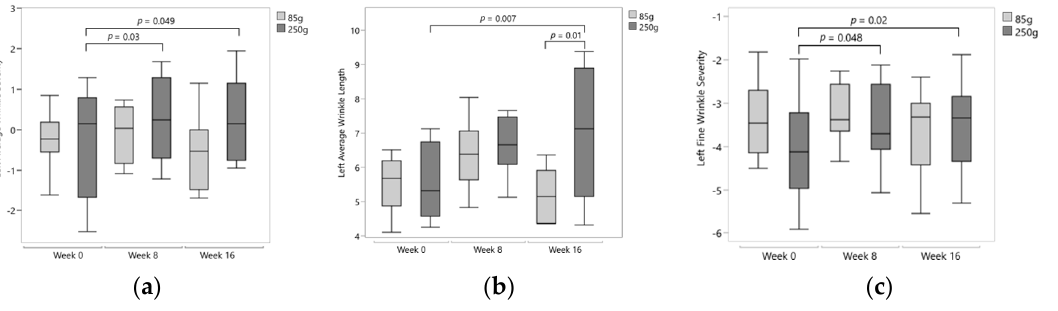
Figure 4. ( a ) Left average wrinkle severity significantly increased at week 8 ( p = 0.03) and week 16 ( p = 0.049) after 250 g of mango intake. Data transformed by Johnson transformation. ( b ) Left average wrinkle length significantly increased at week 16 ( p = 0.007) after 250 g of mango intake and is significantly higher than the 85 g group ( p = 0.01). ( c ) Left fine wrinkle severity significantly increased at week 8 ( p = 0.048) and 16 ( p = 0.02) after 250 g of mango intake. Data transformed by Johnson transformation.